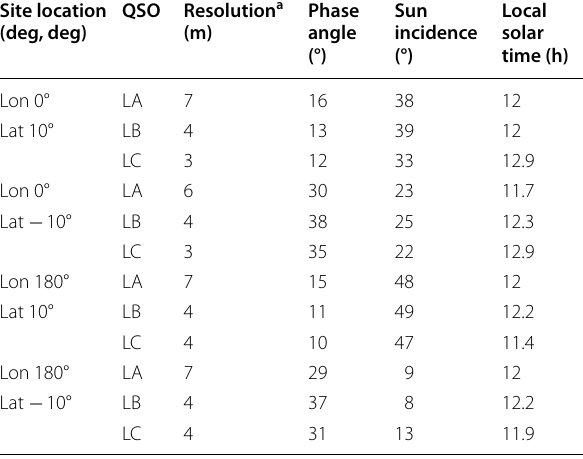
Table 3 Observation conditions at four representative sites for phase angle closest to